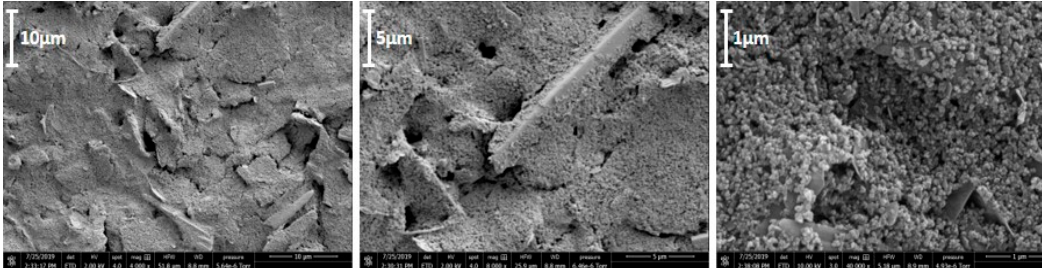
Figure 3. Scanning electron microscopy images of gold-coated working electrode of a CoPC-SPCE. Table 1. Energy dispersive X-ray microanalysis (EDX) of three individual CoPC-SPCEs. Element (% by Weight)